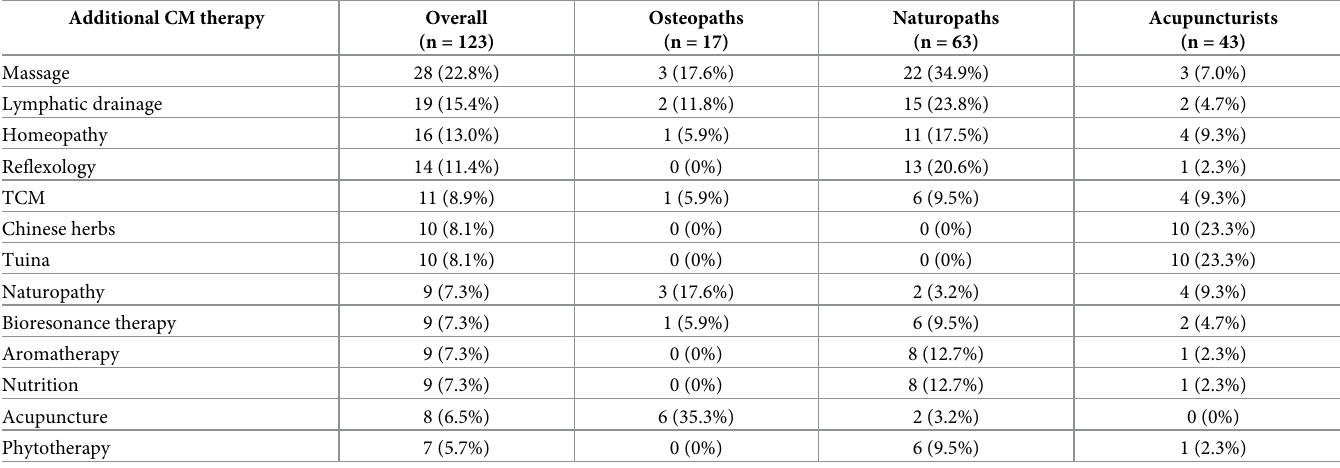
Table 2. Therapists’ other CM training.